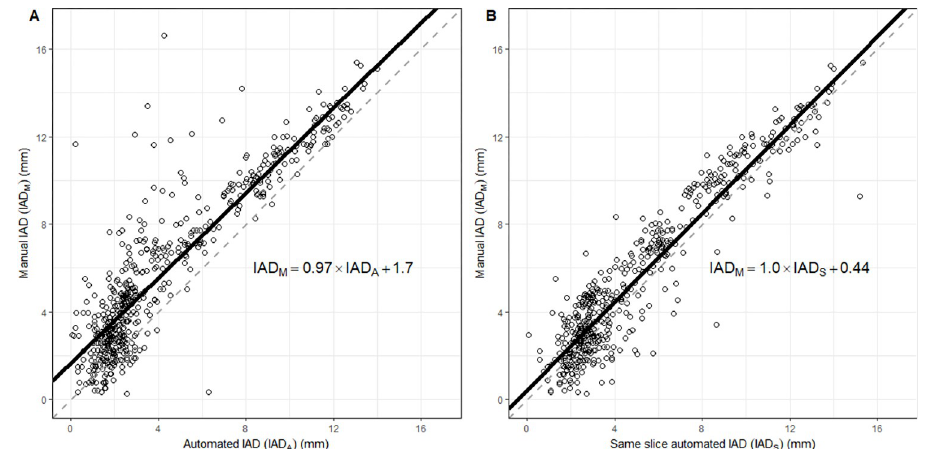
Fig 2. Scatter plots of the paired estimates. 2A compares the paired estimates of the IAD M with IAD A , while 2B compares the paired estimates of IAD M with IAD S . Regression lines are shown as solid black lines with their respective equations provided. The grey dashed lines represent the lines of equivalence.